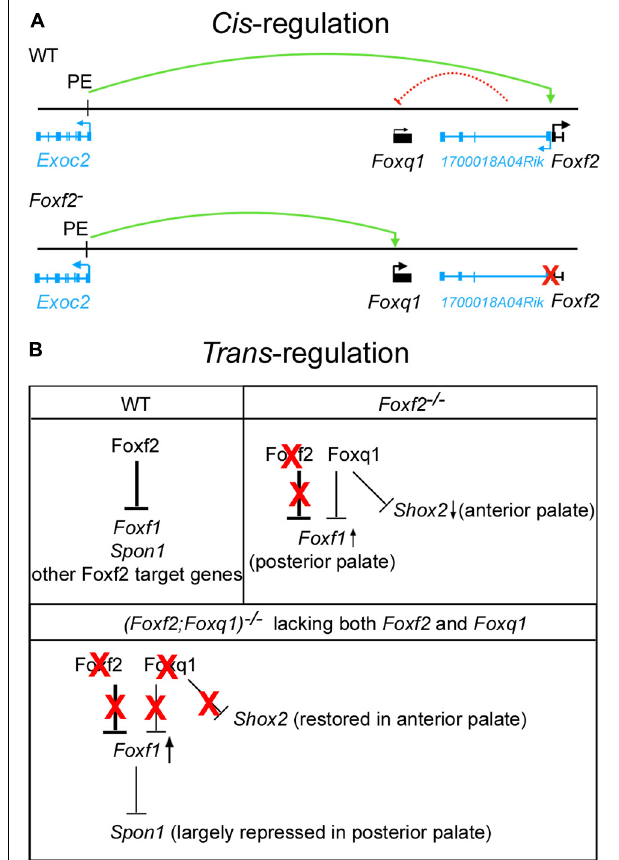
FIGURE 8 | Schematic models of cis -regulation of Foxf2 and Foxq1 expression and of trans- regulation of Foxf1 , Shox2 , Spon1 by Foxf2, and Foxq1 in palate development. (A) Model of mechanisms of cis -regulation of Foxq1 and Foxf2 in palate development. Top panel, in wildtype (WT) embryonic palate, expression of Foxf2 and the 1700018A04Rik lncRNA gene is activated through the bidirectional promoter by distal enhancers, including the one identified in intron-1 of the Exoc2 gene (labeled as PE, for palatal enhancer). Expression of Foxq1 is not activated and may be repressed by the lncRNA transcript or by transcriptional interference from the 1700018A04Rik gene in wildtype embryonic palate. The green curved line with an arrow indicates transcriptional activation by the palatal enhancer. The red dashed curved line from the 1700018A04Rik gene to the Foxq1 gene indicates a hypothetical cis- repression. Bottom panel depicts activation of Foxq1 gene expression in Foxf2 + / − and Foxf2 − / − embryos by the palatal enhancer (PE) due to deletion of the Foxf2 gene promoter (marked by a red X), which also abolished any cis -repressive effect of the 1700018A04Rik gene on the Foxq1 allele. (B) Models of trans- regulation involving Foxf1, Foxf2, and Foxq1. In wildtype embryonic palate, Foxf2 is strongly expressed in the posterior region of palatal shelves and represses expression of Foxf1 , Spon1 , and multiple other target genes as previously identified (Xu et al., 2020) in the posterior palatal mesenchyme. In Foxf2 − / − embryonic palate, Foxf2 protein is absent (marked by red X over “Foxf2”) but Foxq1 was activated in both the anterior and posterior regions of the palatal shelves. The increased Foxq1